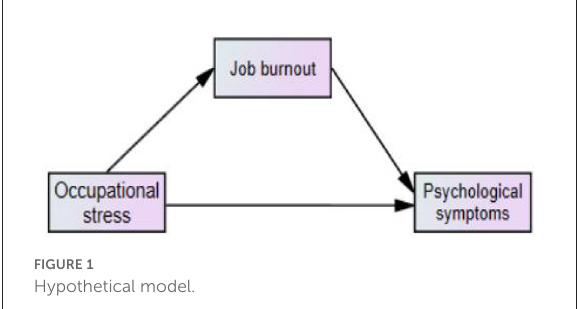
FIGURE1 Hypothetical